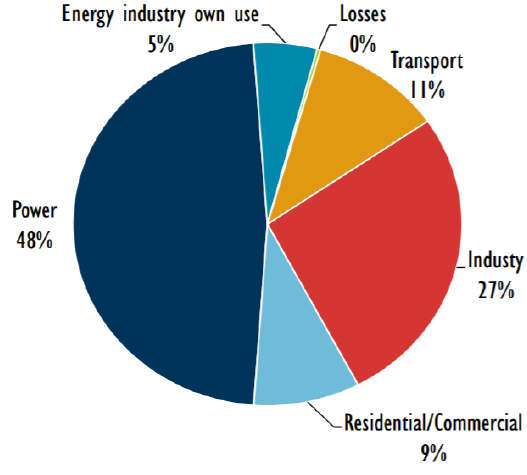
Figure 2. Global natural-gas consumption by sector (2014–2020) [66].